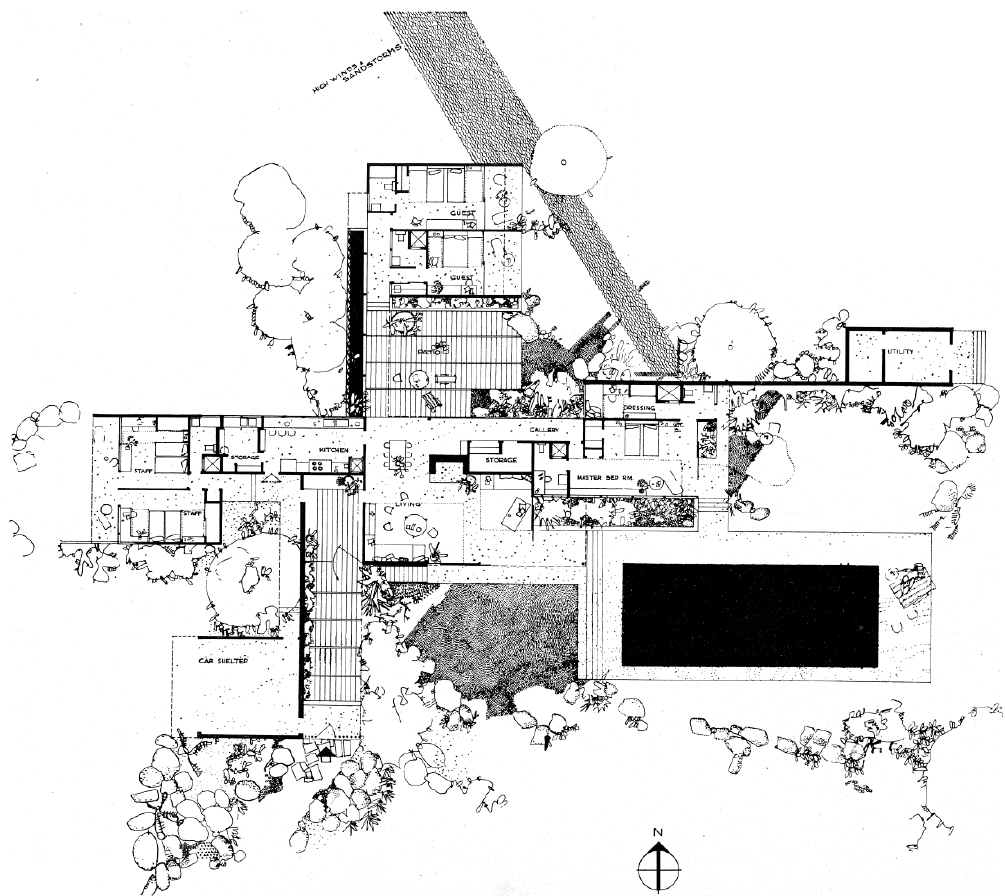
Figure 5. Richard Neutra, Kaufmann Desert House, Palm Springs, 1946–1947. Plan. (Published in Boesiger 1951, p. 71, permission courtesy Dion Neutra, architect ©).